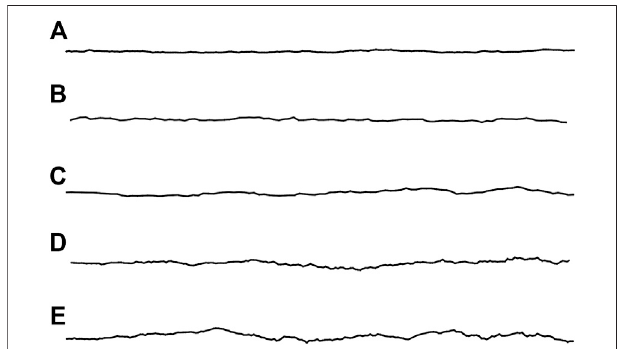
FIGURE 1 | Random morphology rock joint pro fi les with different JRC values. (A) J1 (JRC= 2.398). (B) J2 (JRC= 7.593). (C) J3 (JRC =12.481).